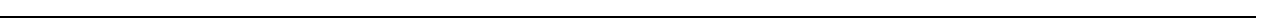
Fig. 2 Aberrant RNA editing re-codes GLI1 transcripts. a Schematic representation of the GLI1 editing site in a putative SUFU binding domain. b Vienna RNA predicted secondary structure changes of GLI1 induced by A-to-I editing in exon 12. c RESSq-PCR analysis of GLI1 editing in primary MM total MNCs. Dots represent ratio of edit (G)/WT (A) GLI1 transcripts (mean values for individual patients ± S.E.M.; ctrl n = 3, smoldering MM n = 4, newly diagnosed MM n = 4, relapsed MM n = 7, PCL n = 4). * p < 0.05, ** p < 0.01, by unpaired, two-tailed Student ’ s t -test. d Representative Sanger sequencing chromatograms for GLI1; the yellow box highlights the double peak A/G, labeled with the percentage of edited transcripts assessed as edit allele burden (%G/(G + A)). e Regression analysis of total ADAR1 mRNA expression and GLI1 editing levels in primary samples ( n = 19). f Top 5 gene sets enriched in 1q amp ( n = 40) from CoMMpass RNA-seq (IA7 data release) ranked by gene set size. g Venn diagram showing number of core enriched genes between KEGG_Pathways in Cancer and KEGG_Signaling Pathways Regulating Pluripotency of Stem Cells. h Enrichment of Hedgehog signaling in high versus low ADAR1